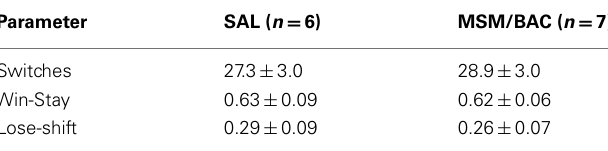
Table 1 | Mean ( ± SEM) values of behavior related parameters for saline-treated and MSM/BAC-treated rats in trial block 61–120 in good performing animals (trial block 41–60).